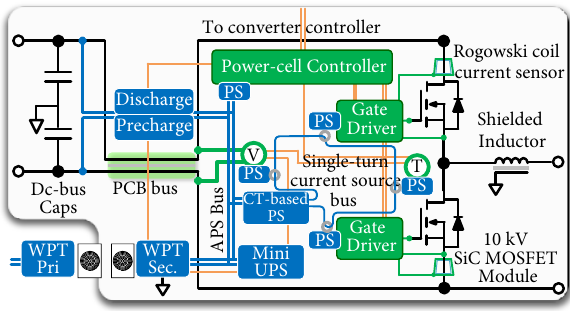
Fig. 1 Developed medium-voltage half-bridge power-cell system archite- cture diagram.